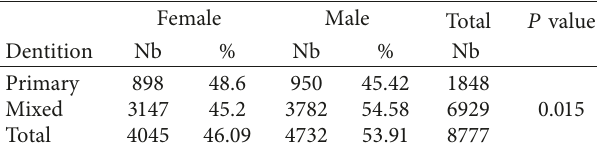
Table 2: Comparison between the number of dental treatments performed in both genders and the dentition